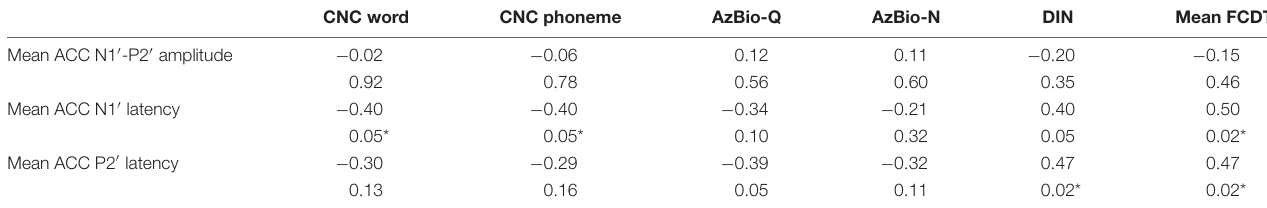
TABLE 2 | Correlation analysis of ACC measures and behavioral performance. CNC word CNC phoneme AzBio-Q AzBio-N DIN Mean FCDT